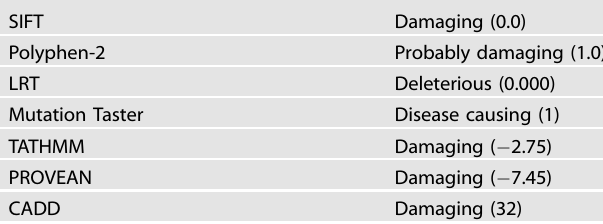
Table 2. In silico pathogenicity analyses of F175